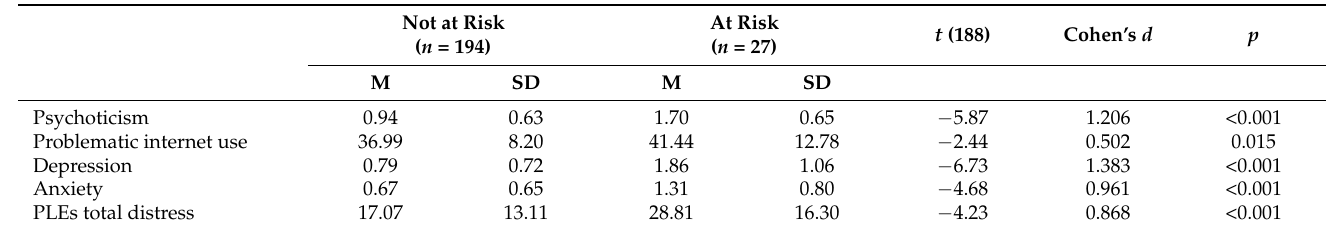
Table 4. Descriptive statistics according to risk for hikikomori (indicated by a HQ-25 score of 42 or above).